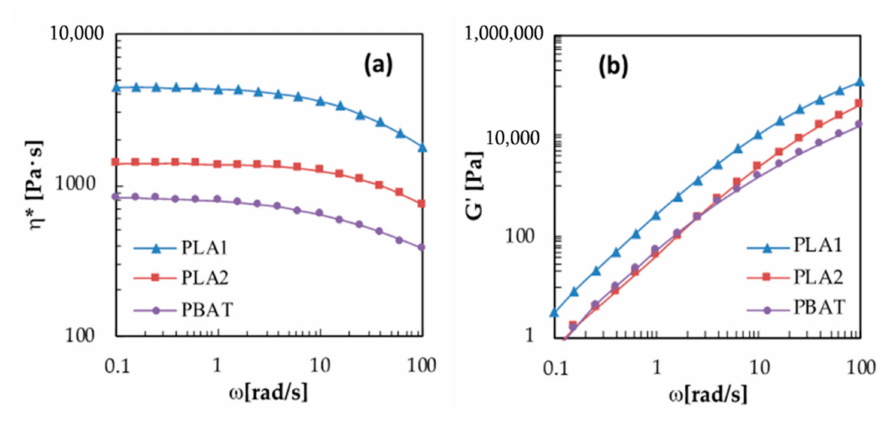
Figure 1. ( a ) Complex viscosity and ( b ) Storage Modulus of the neat polymers.